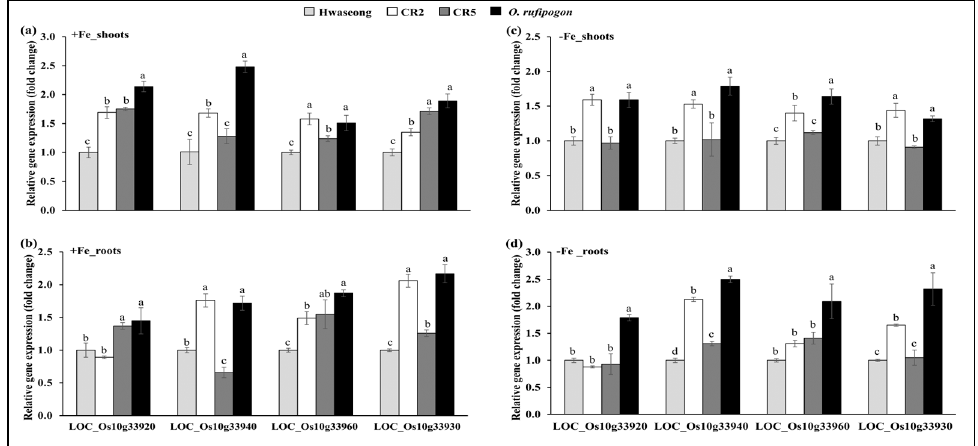
Figure 4. Quantitative real-time PCR analysis of the four candidate genes covering the qFe10 region. Relative expression levels of the four candidate genes in shoot tissues under ( a ) +Fe and ( c ) -Fe treatment conditions. Relative expression levels of the four candidate genes in root tissues under ( b ) +Fe and ( d ) -Fe treatment conditions. The mean values with different letters are significantly different from each other at p = 0.05 based on Tukey’s test. Error bars represent the ± standard deviation of the mean. All values represent the mean of three replicates.